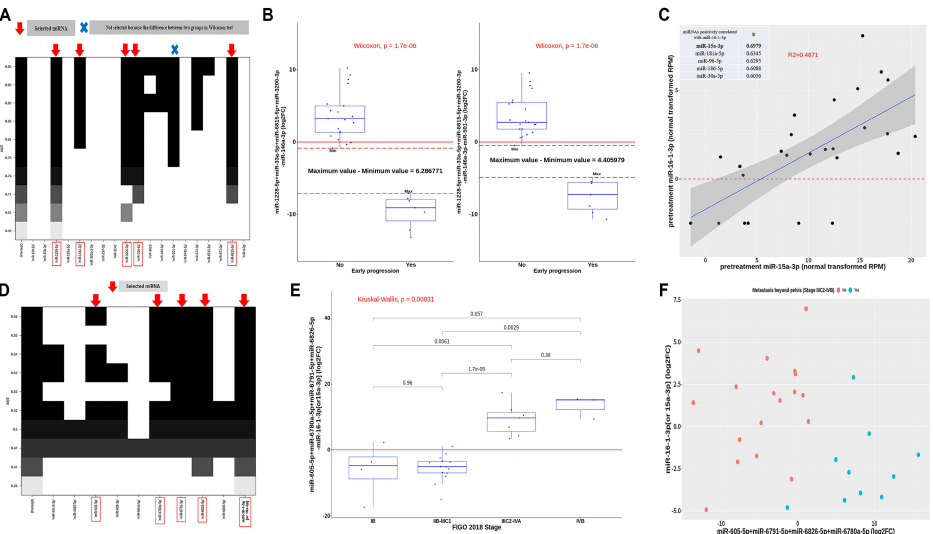
Figure 2. Selection of miRNAs associated with early progression and stage in cervical cancer. ( A ) Five miRNAs, selected after obtaining adjusted R values from multiple regressions of all possible combinations of 19 miRNAs, were significantly associated with early progression. ( B ) In two groups related to early progression status, the difference of sum and subtraction of the selected 5 miRNAs was greater than that of the six selected miRNAs. ( C ) Pre-treatment normal transformed miR-16-1-3p correlated better with miR-15a-3p among all miRNAs. ( D ) Five miRNAs, selected after obtaining adjusted R values from multiple linear regressions of all possible combinations of 10 miRNAs, were significantly associated with stage. ( E ) Sum and difference of the selected 5 miRNAs were positively correlated with stage. ( F ) Correlation between miR-605-5p+miR-6791-5p+miR-6826-5p+miR-6780a- 5p, miR-16-1-3p (or 15a-3p), and extrapelvic